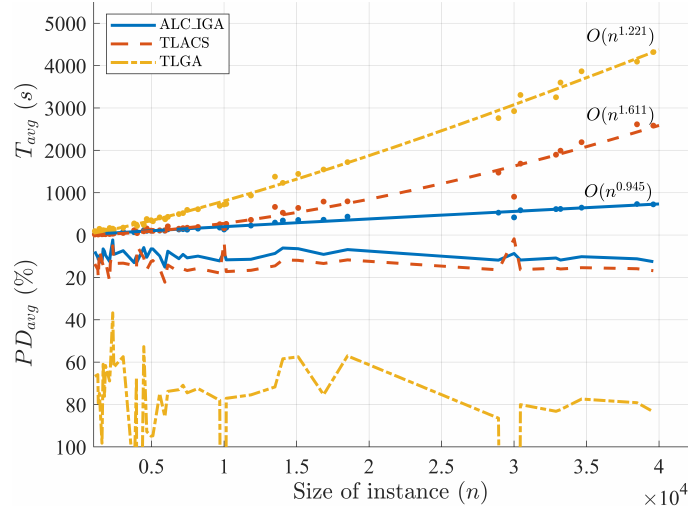
Figure 8. The computation time analysis of the proposed algorithm; TLGA and TLACS in sin- gle thread.